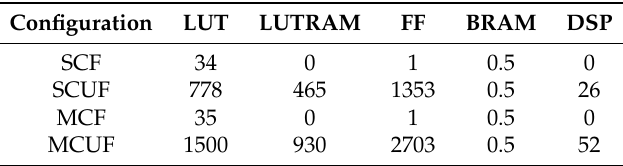
Table 1. System resource